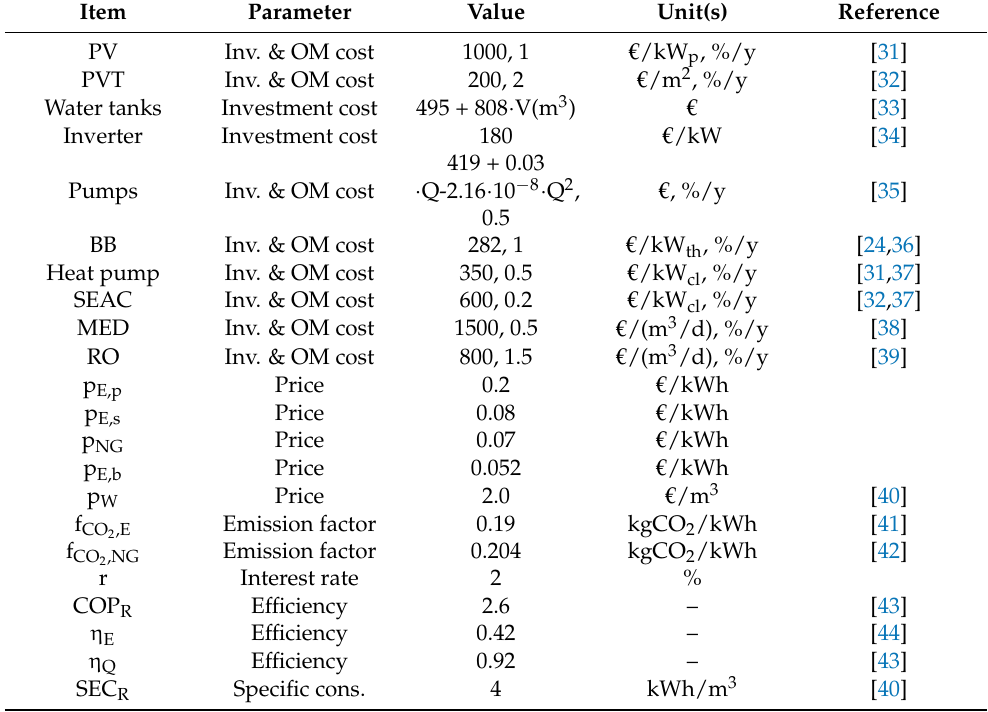
Table 6. Main economic and environmental parameters of the